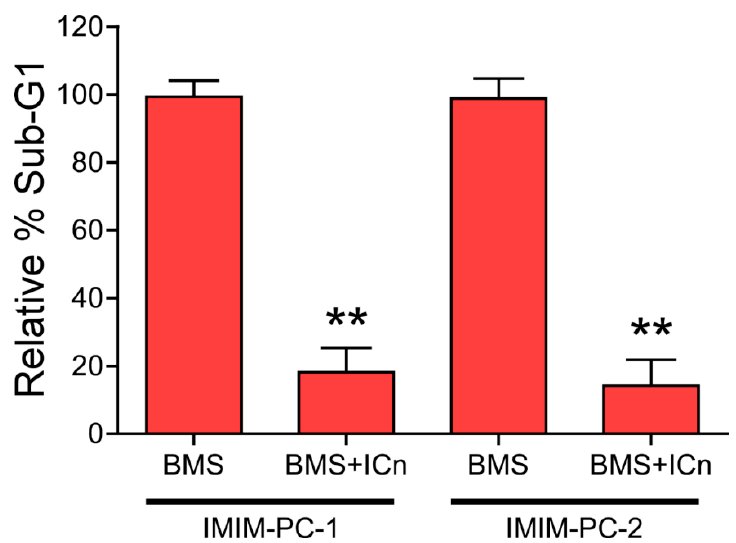
Figure 5. Effect of a pan-caspase inhibitor on cell death induced by BMS-754807. IMIM-PC-1 and IMIM-PC-2 cell lines were treated with 10 µM BMS-754807 (BMS) in the presence or absence of 25 µM Z-VAD-FMK (ICn) for 24 h, and the number of cells in the sub-G 1 phase of the cell cycle was determined by flow cytometry. Data represent the mean ± SEM ( n ≥ 3), taking the number of BMS-treated, ICn-untreated cells in sub-G 1 phase as 100%. **, p < 0.01.